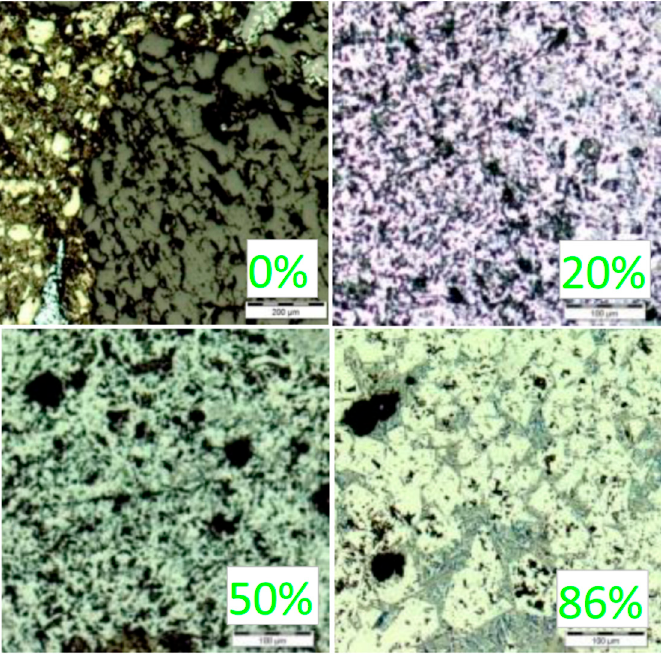
Figure 15. Microstructure of sinters with coke substitution by lignin.